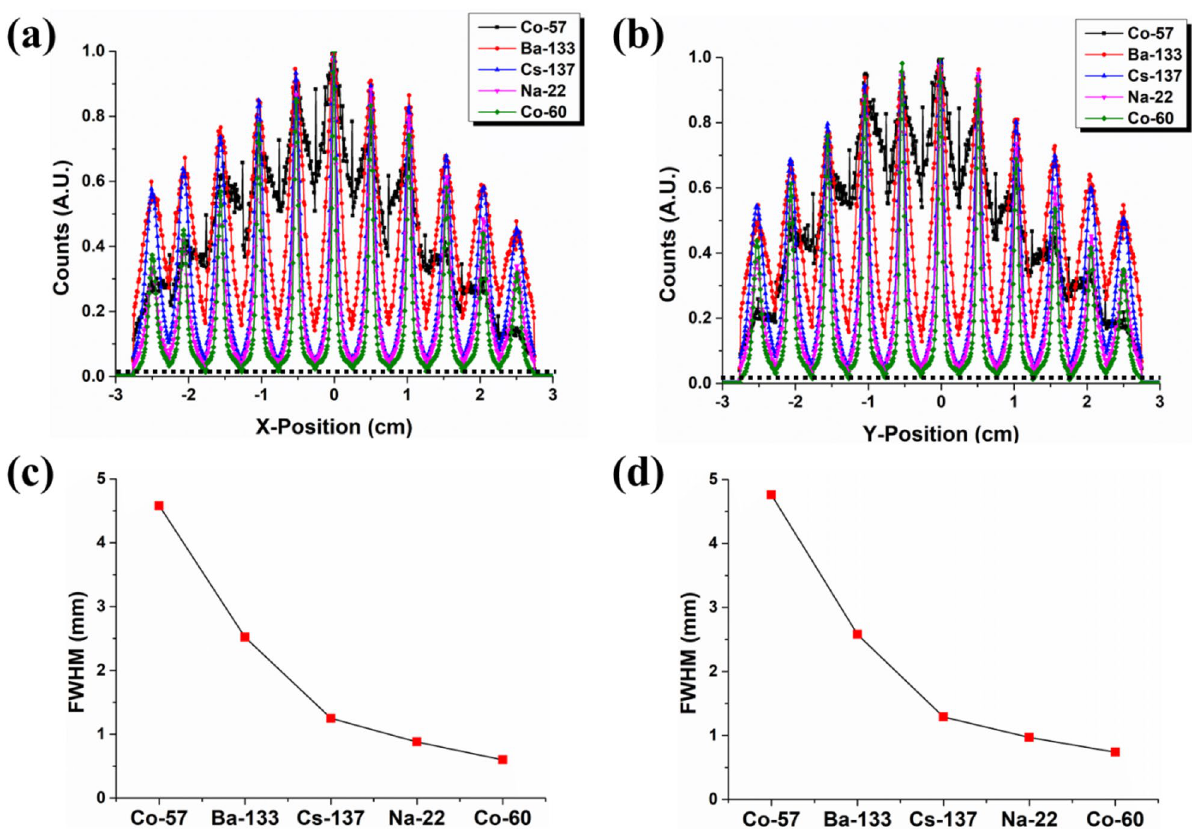
Figure 2. ( a ) 1D row-sum profile and ( b ) 1D column-sum profile derived from the flood map in Fig. 1 The corresponding FWHM resolution of the pixel-center for all row pixels ( c ) and column pixels ( d ) as the radionuclide is varied.